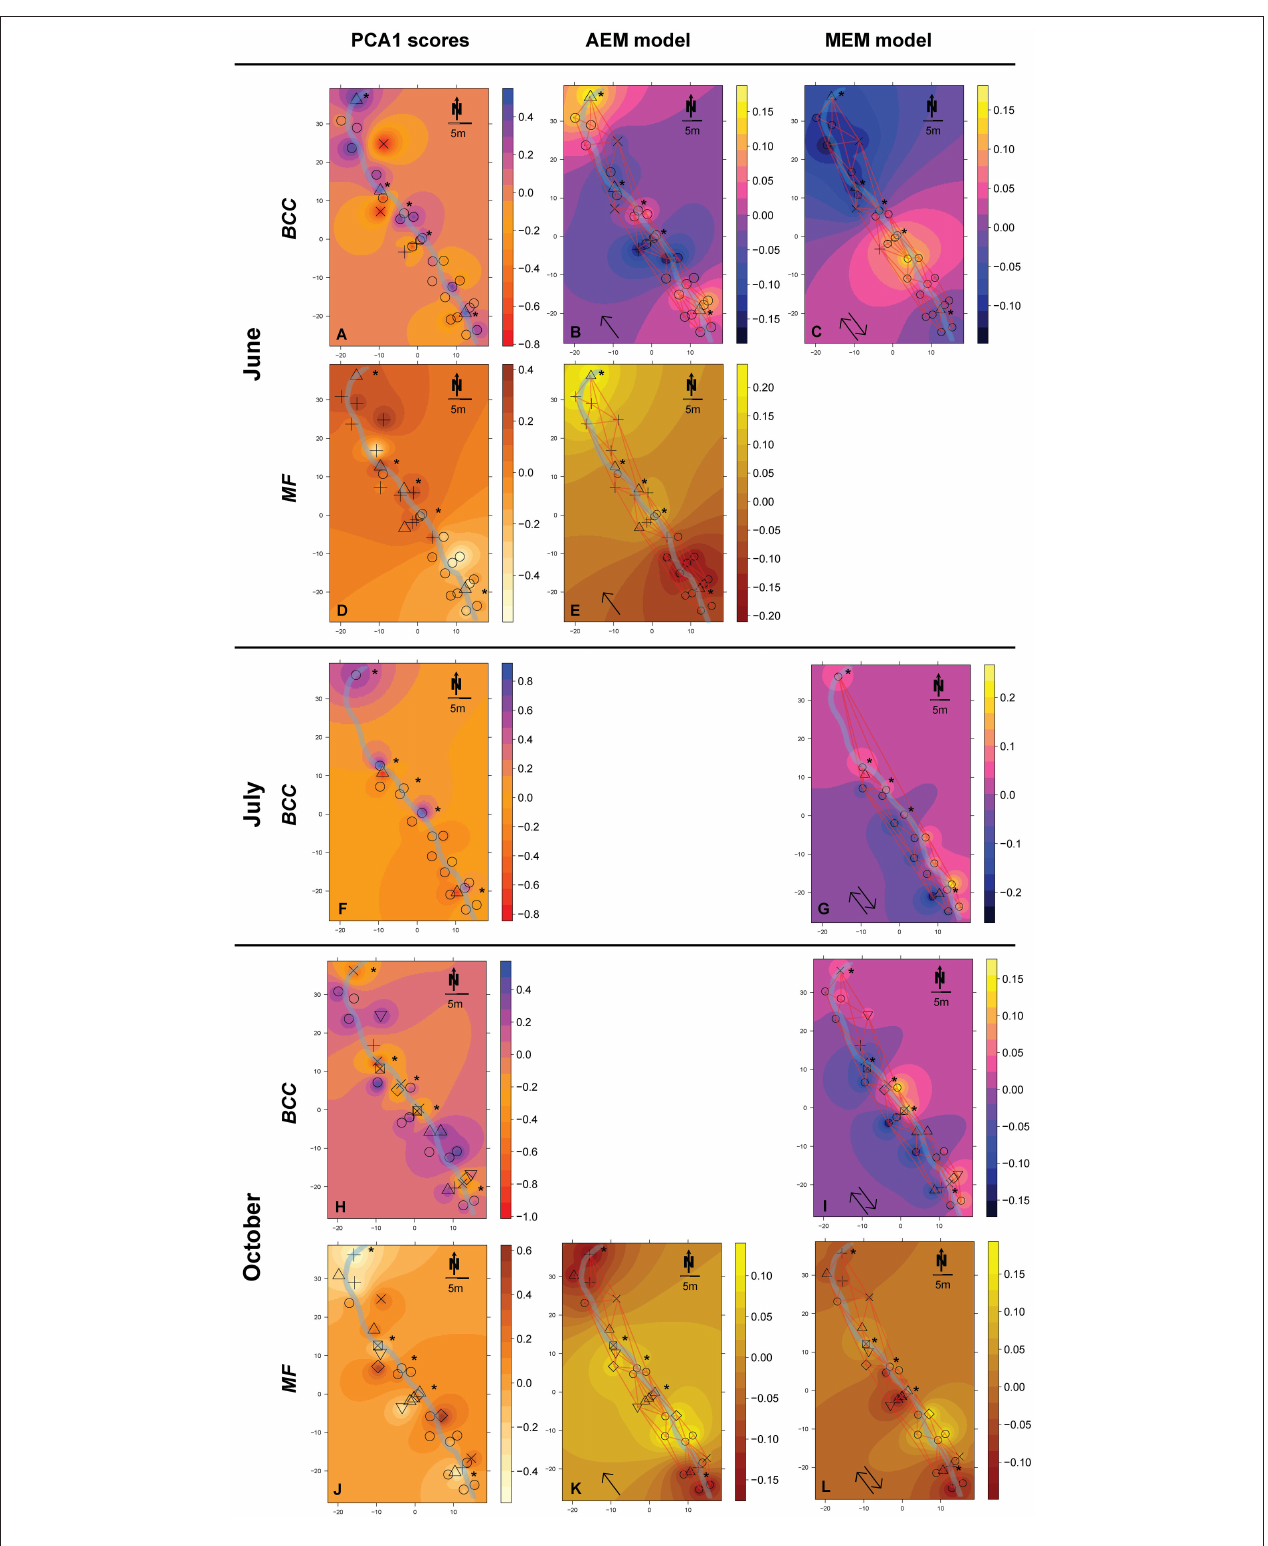
FIGURE 3 | Spatial maps of IDW inter- and extrapolations of PCA1 scores and first RDA axis values constrained by spatial explanatory variables from the significant AEM and MEM models for BCC (pink-yellow color scheme) and MF (orange color scheme) at site RC. The piezometer locations and the used connectivity grid are depicted. Symbols represent the relative affiliation of MF or BCC derived from the cluster analysis; i.e., same symbols indicate a high